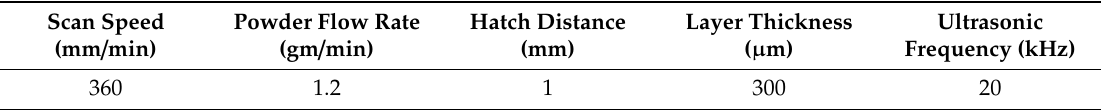
Figure 1. Schematic illustrations of ultrasonic-assisted laser metal deposition: ( a ) experimental device; and ( b ) deposited layer size and scan path. Table 2. Fixed process